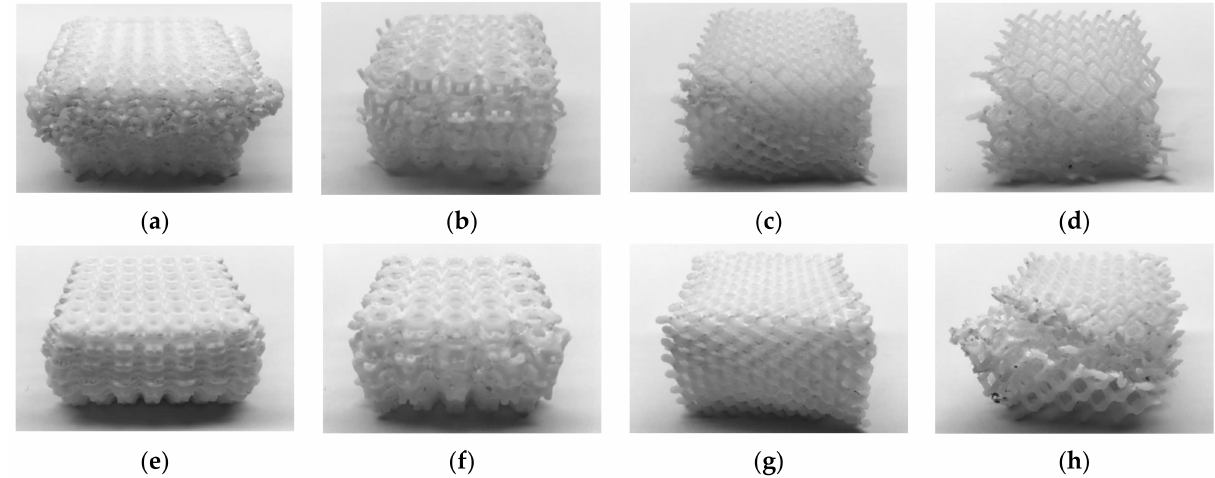
Figure 8. ABS printed and tested samples ( a ) 001; ( b ) 002; ( c ) 003; ( d ) 004; ( e ) 005; ( f ) 006; ( g ) 007; and ( h ) 008.